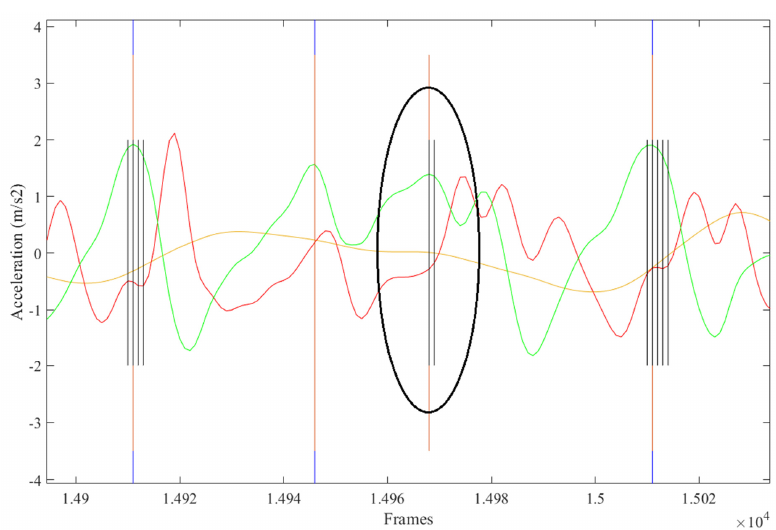
Figure 7. Extra FS inserted by AI